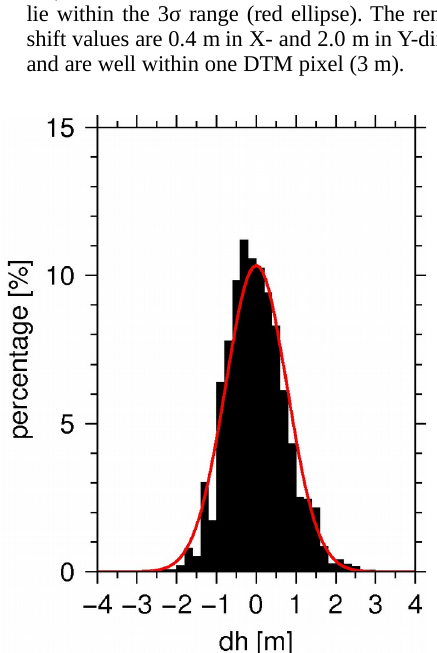
Figure 6: The height residuals of all available (registered) LOLA shots and the adjusted LROC NAC DTM are normal distributed around a mean of ~0.0 m with a standard deviation (1σ) of 0.77